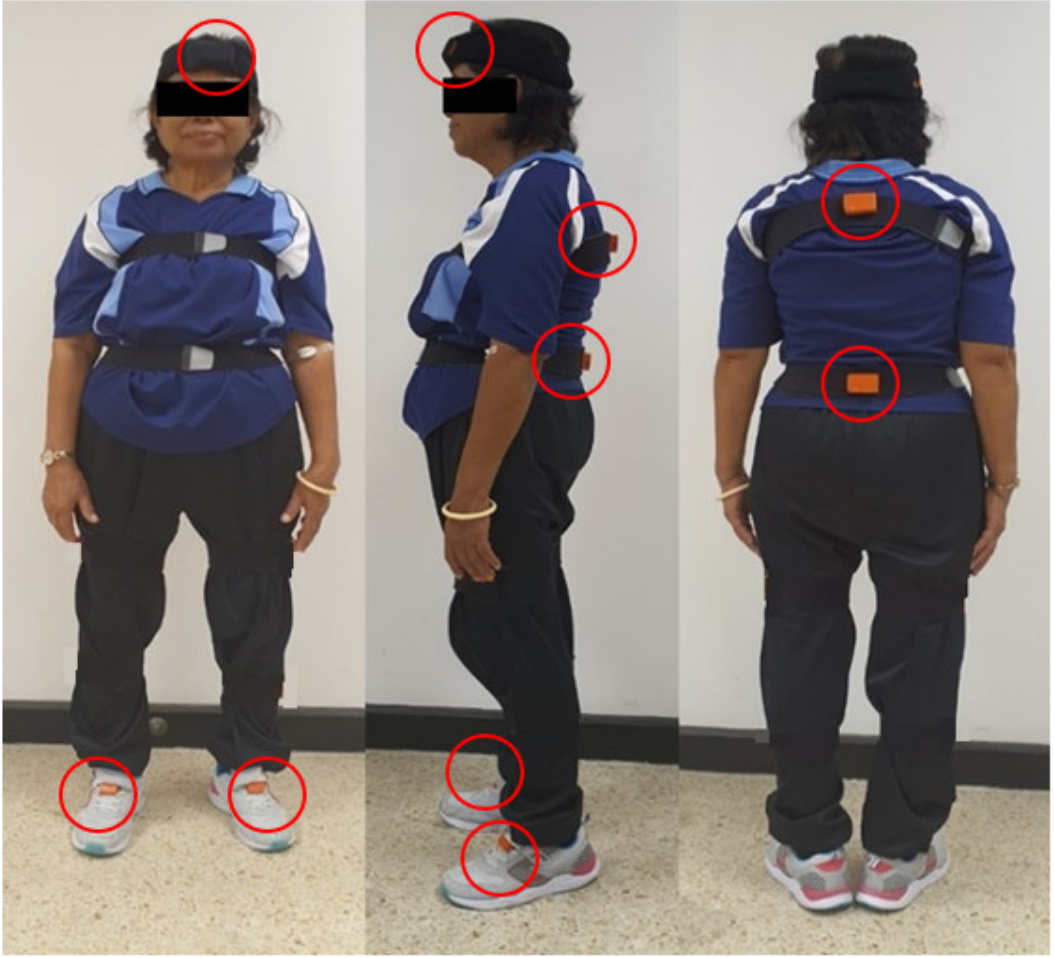
Figure 1. Location of the positioning of the XSENS IMU sensors.